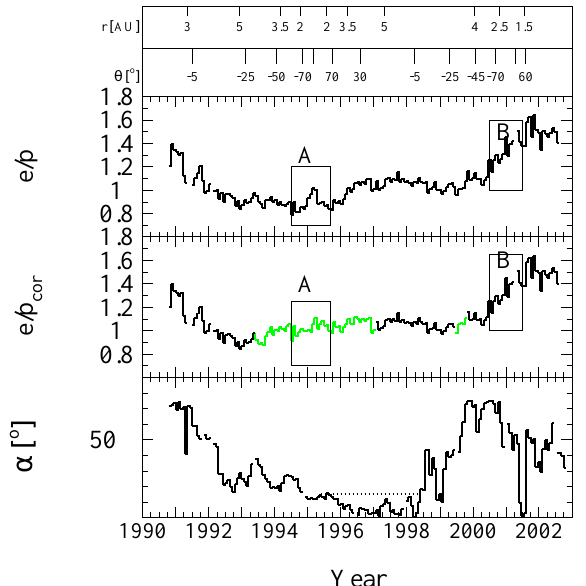
Fig. 9. From top to bottom: Measured 26-day averaged 2.5 GV e/p -ratio from launch to mid 2002 along the Ulysses orbit. The second panel displays the “heliographic equator equivalent” e/p - ratios as described in the text. Periods “A” and “B” mark the time period of the minimum and maximum fast latitude scans. The low- est panel shows the evolution of the maximum latitudinal extent of the heliospheric current sheet α shifted by 5 solar rotations to later times (http://quake.stanford.edu/ ∼ wso/). Ulysses’ distance to the Sun and its heliographic latitude are shown at the